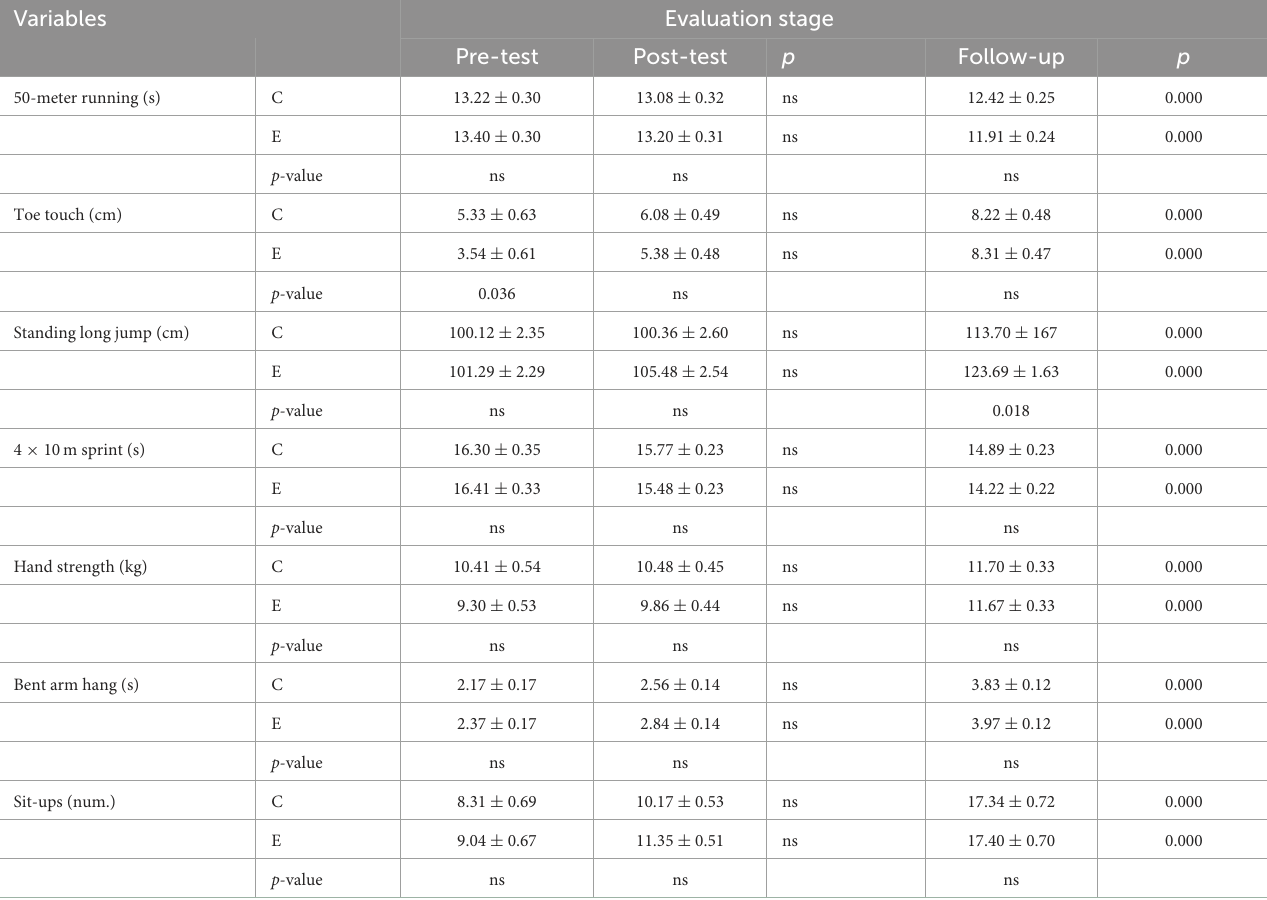
TABLE 2 The mean and standard deviation (SD) of the fitness test obtained by pupils from the experimental and control groups in the pre, post, and follow-up tests.